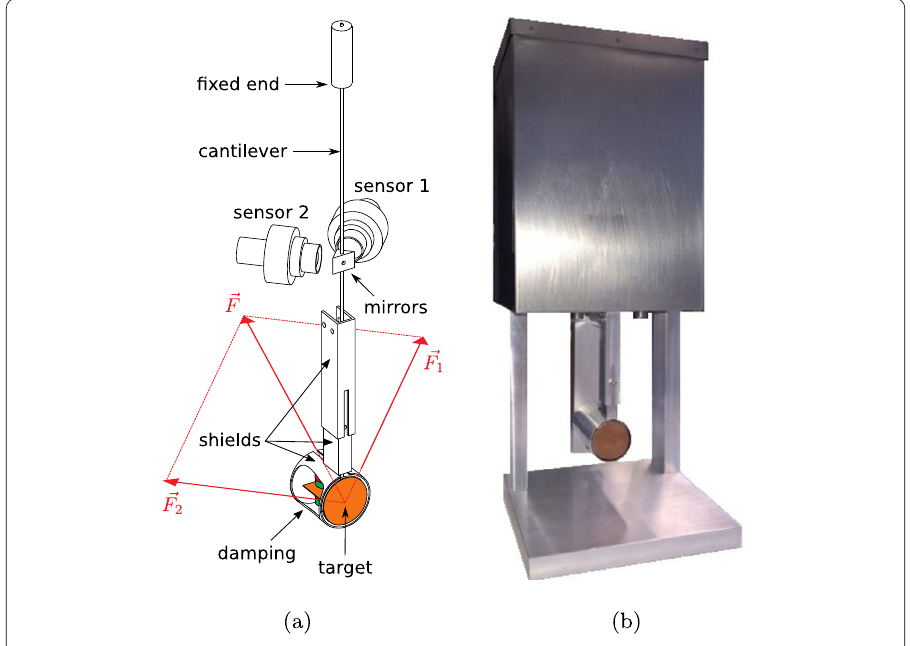
Figure 1 Two-axes force probe. ( a ) View of the essential components with the force acting on the probe target. Note that the force F is in general not perpendicular to the target. ( b ) Photo of the capsulated